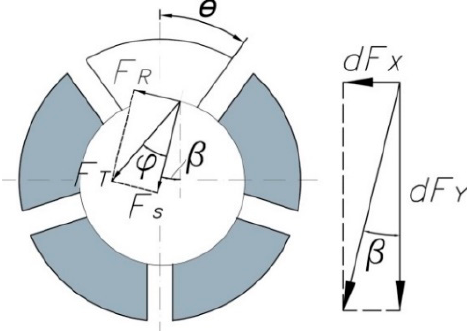
Figure 7. Contact pressure and forces on collet workpiece.